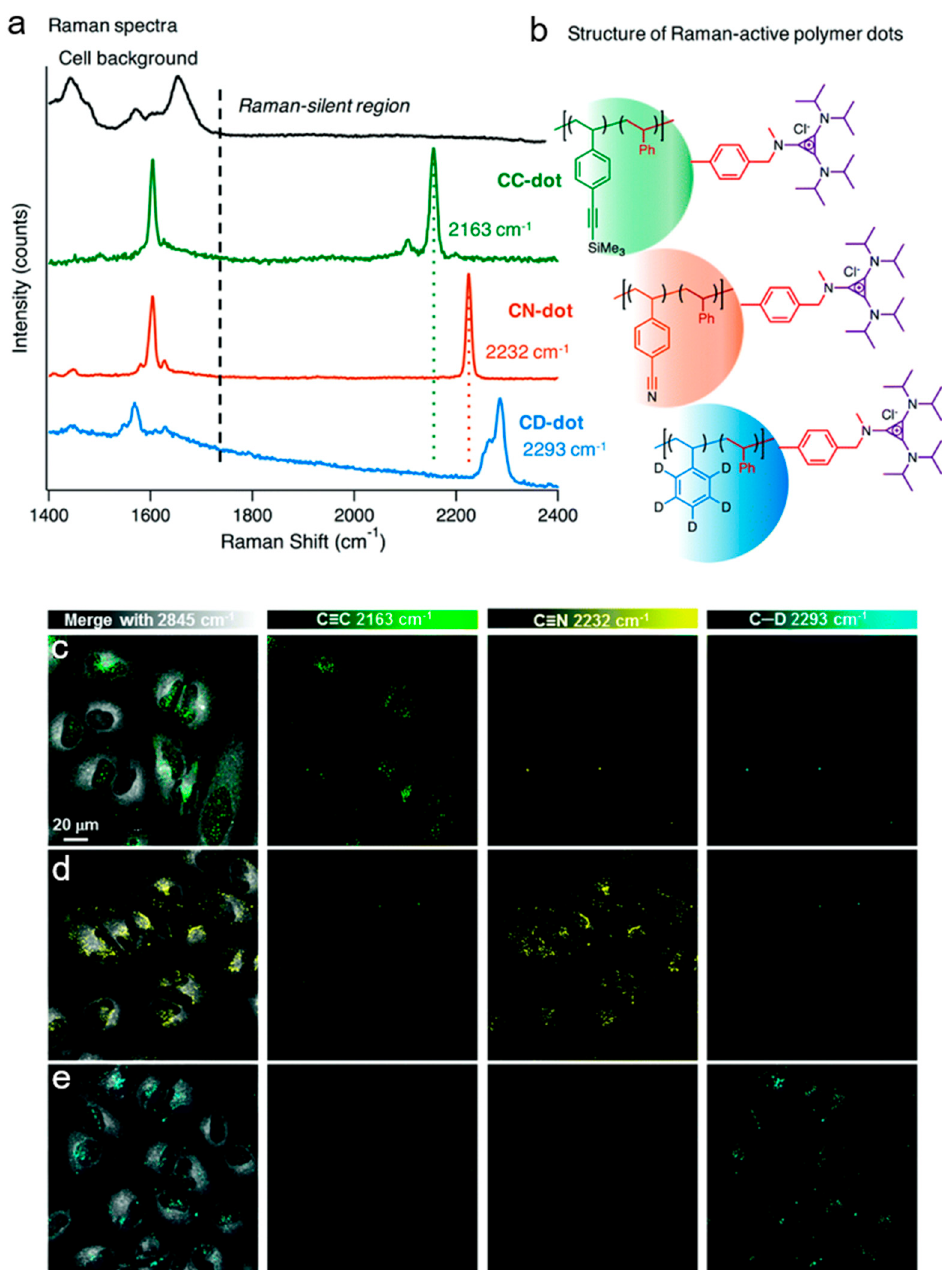
Figure 7. Analysis of Raman-active polymer dots using spontaneous Raman spectroscopy and SRS imaging. ( a ) Raman spectra of nanoparticles with orthogonal groups in the cell silent region (1800–2800 cm − 1 ). ( b ) Corresponding structures of the Raman-active polymer dots, comprising of a core of styrene and styrenic derivatives (C ≡ C, C ≡ N and C–D labelled styrene) and surface-coated with trisaminocyclopropenium (TAC) groups. ( c – e ) SRS imaging of Raman-active polymer dots in live HeLa cells. The polymer dots are detected at discrete frequencies in the HeLa cells: ( c ) C ≡ C dot (2163 cm − 1 ), ( d ) C ≡ N dot (2232 cm − 1 ), and ( e ) C–D dot (2293 cm − 1 ), with the cellular contrast detected at 2845 cm − 1 (CH 2 , lipids) in the merge images. Reproduced with permission from [90], Copyright Royal Society of Chemistry, 2017.